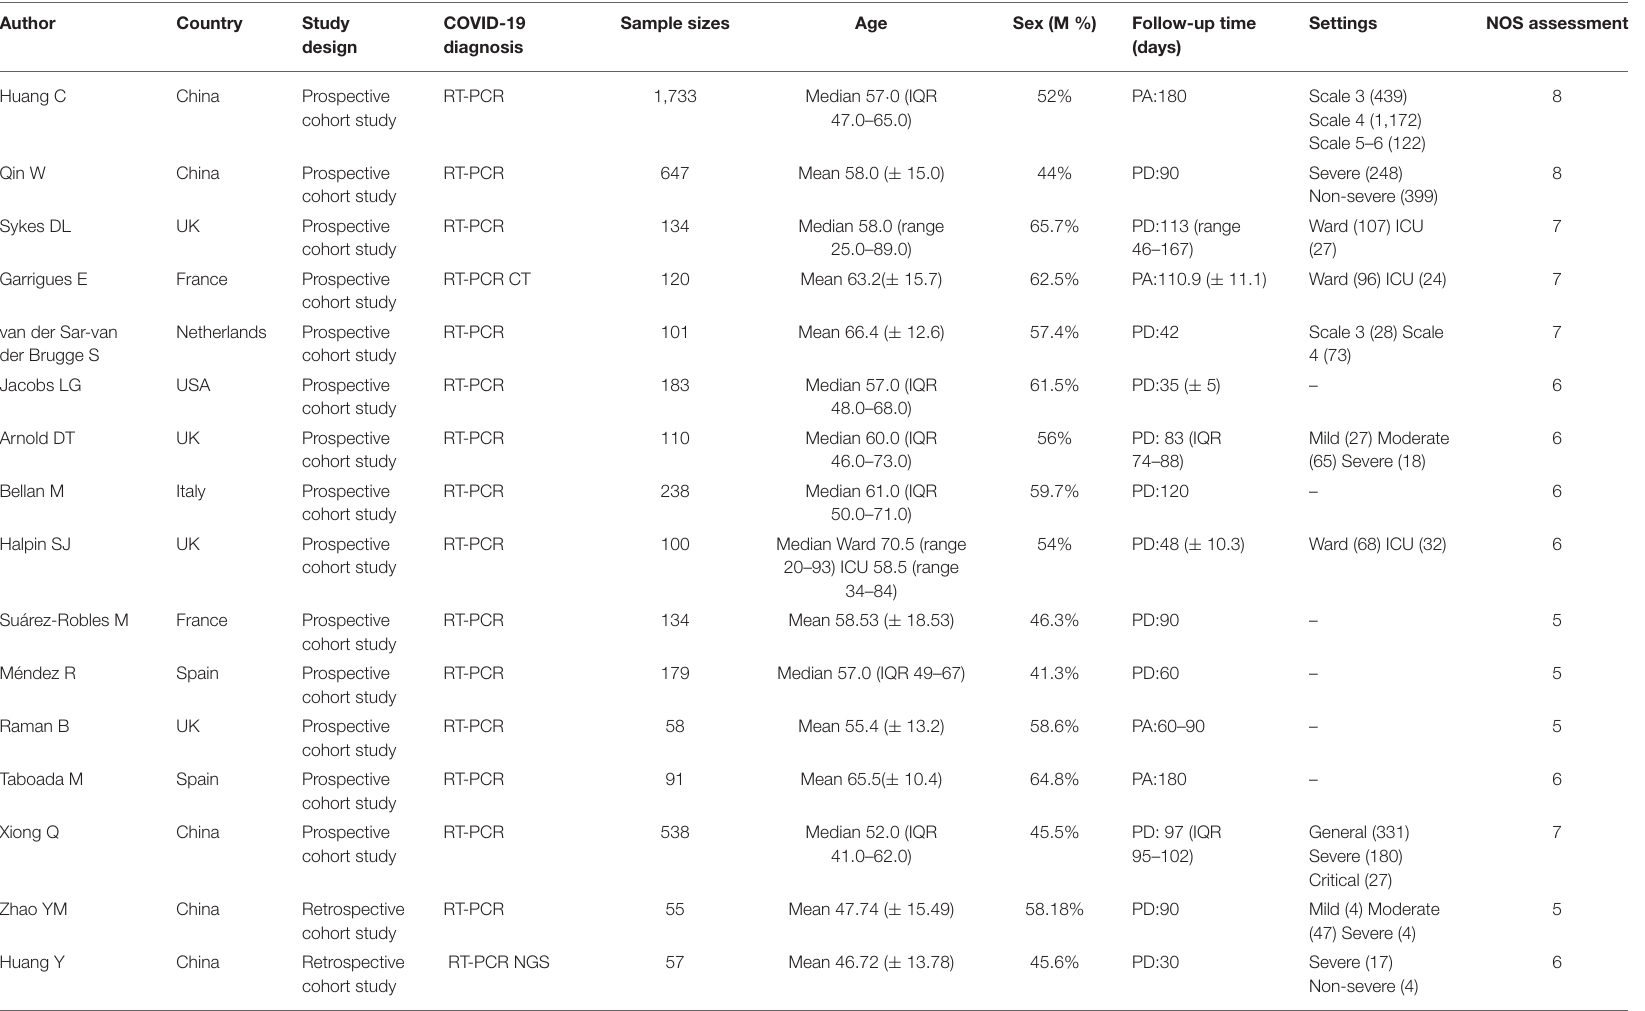
TABLE 1 | Main characteristics of included studies in the